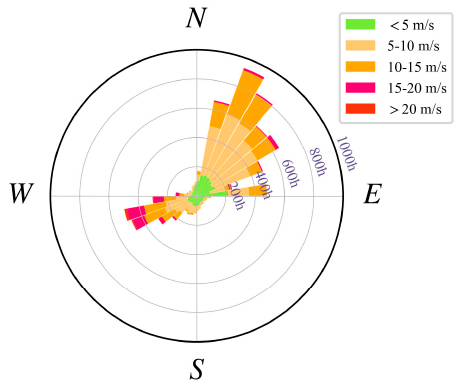
Figure 8. Wind speed–orientation distribution map.